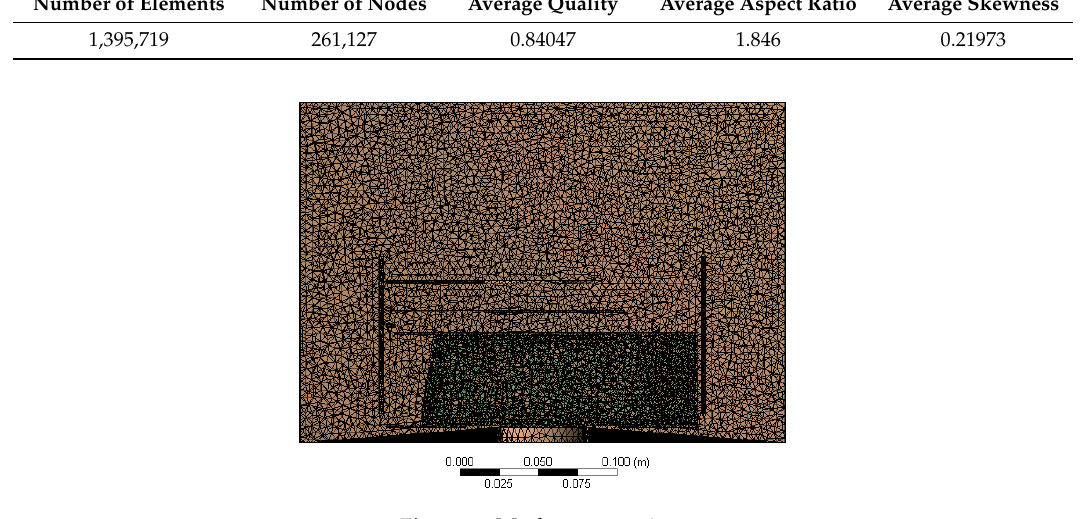
Figure 3 . Mesh cross section.